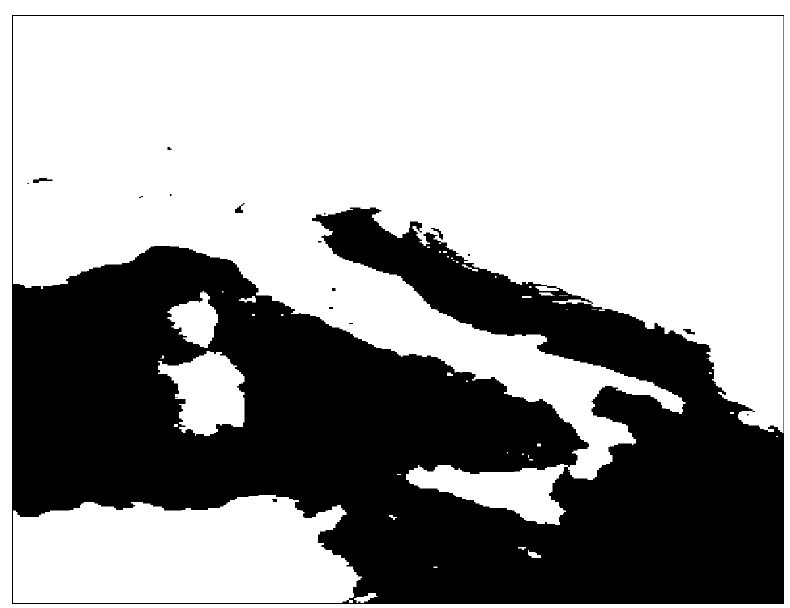
Figure 5. Sea-mask : black regions represent occulted pixels.